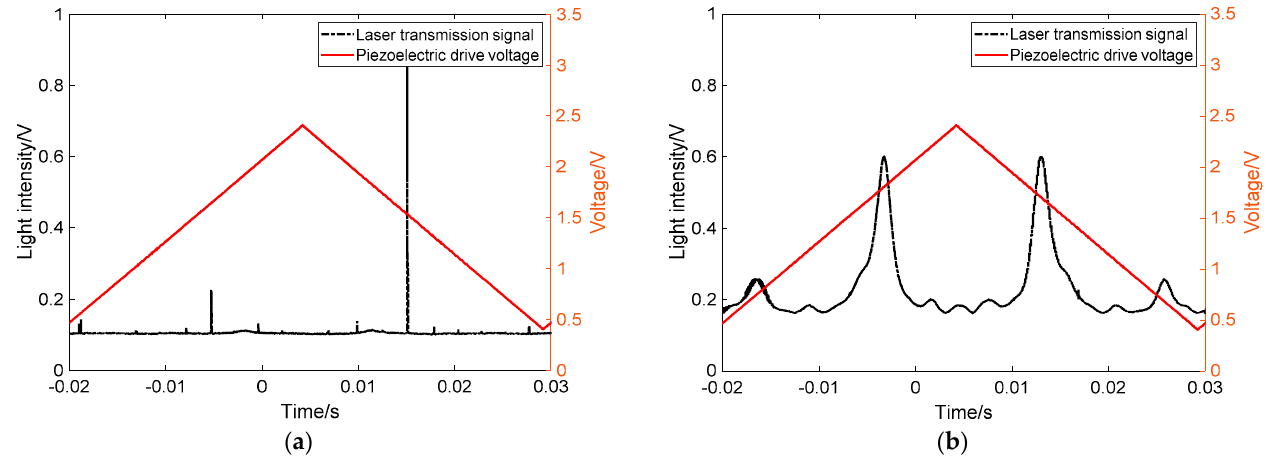
Figure 5. Resonant light signal by turning the line polarizer between mirror M2 and the collimator. ( a ) The signal of S-Polarized direction; ( b ) the signal of P-Polarized direction.